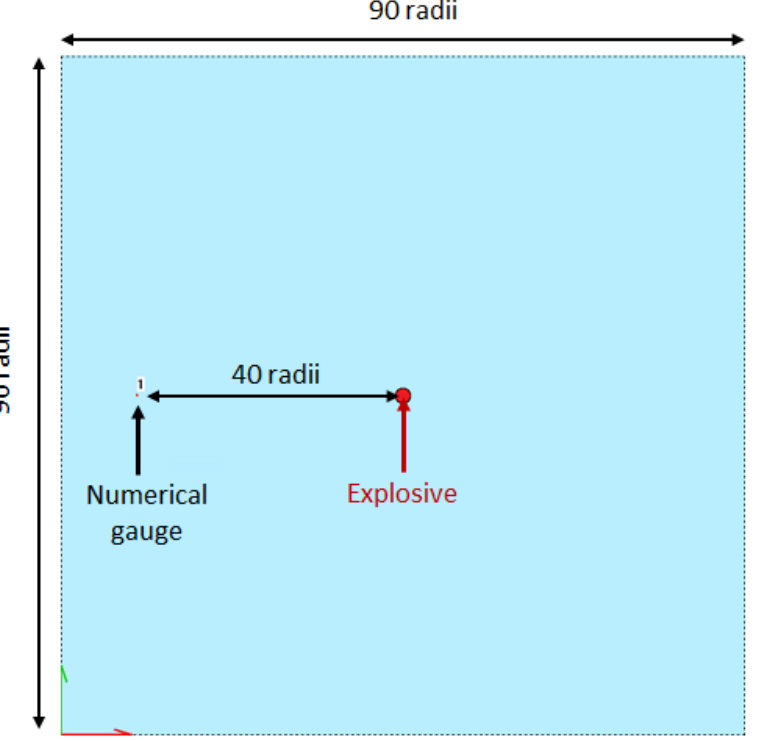
Figure 12. Configuration of the mesh sensitivity study simulation study performed with SPEED ® . An explosive is set in the centre of the mesh domain with a numerical gauge at 40 radii away from it. The element size varies from 0.05 mm to 2 mm, and the domain is a 90 radii